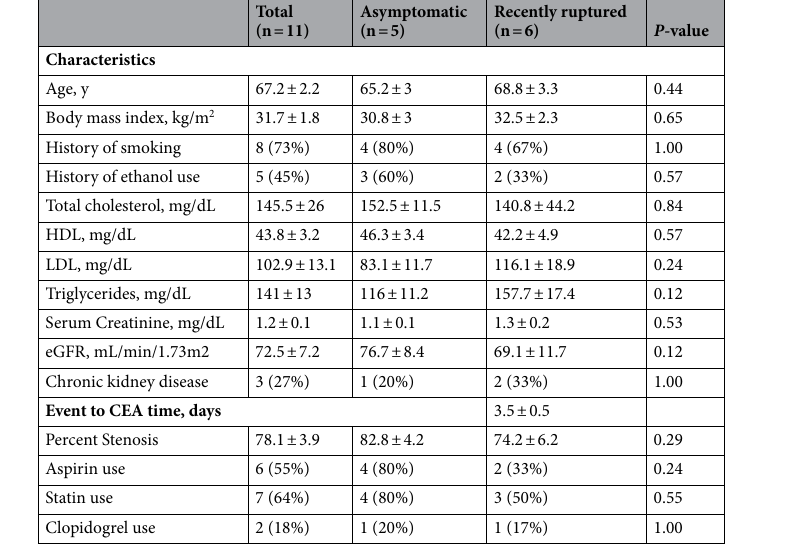
Table 1. Patient characteristics. Data expressed as mean ±